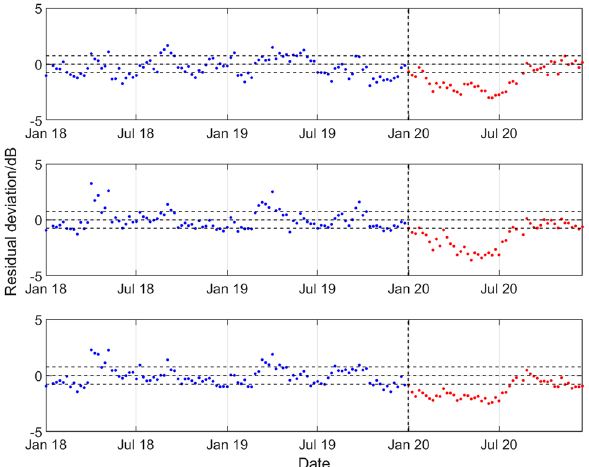
Figure 8. Results for the northern triplet hydrophone H10N1 data recorded at the CTBT Ascension Island station, statistical level P 10 and (top to bottom) low, medium, and high frequency bands. For the period January 2018 to December 2019 and during 2020, deviations of the observed weekly SPSDL data from the predictable part of the signal defined by the long-term and medium-term seasonal components of the GP model.